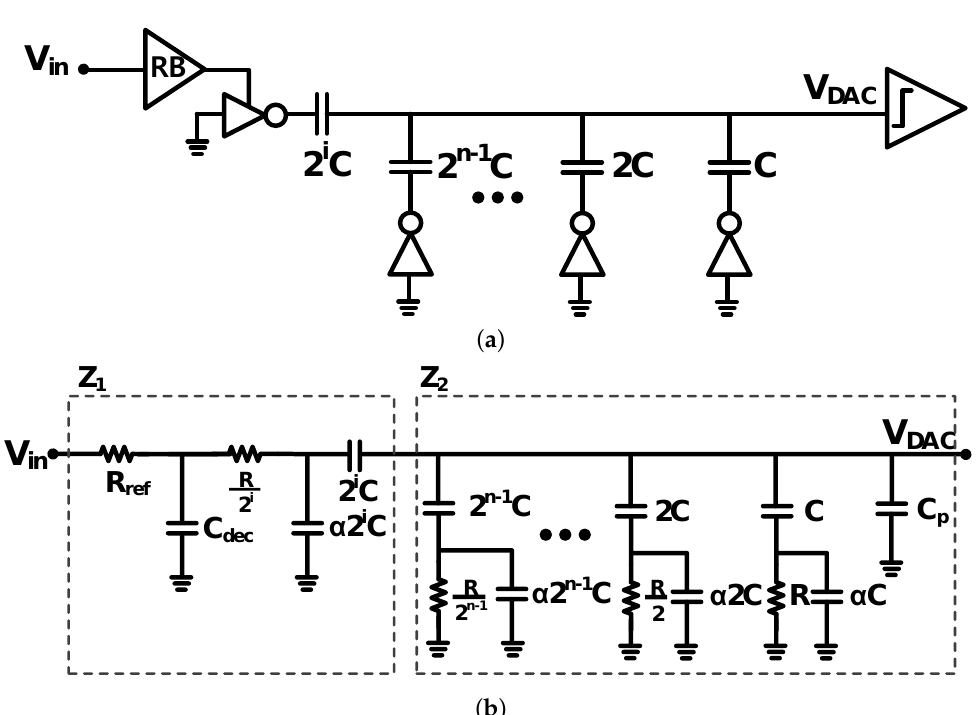
Figure 2. ( a ) Capacitive DAC array with reference buffer and ( b ) modeling circuit in i th conver- sion